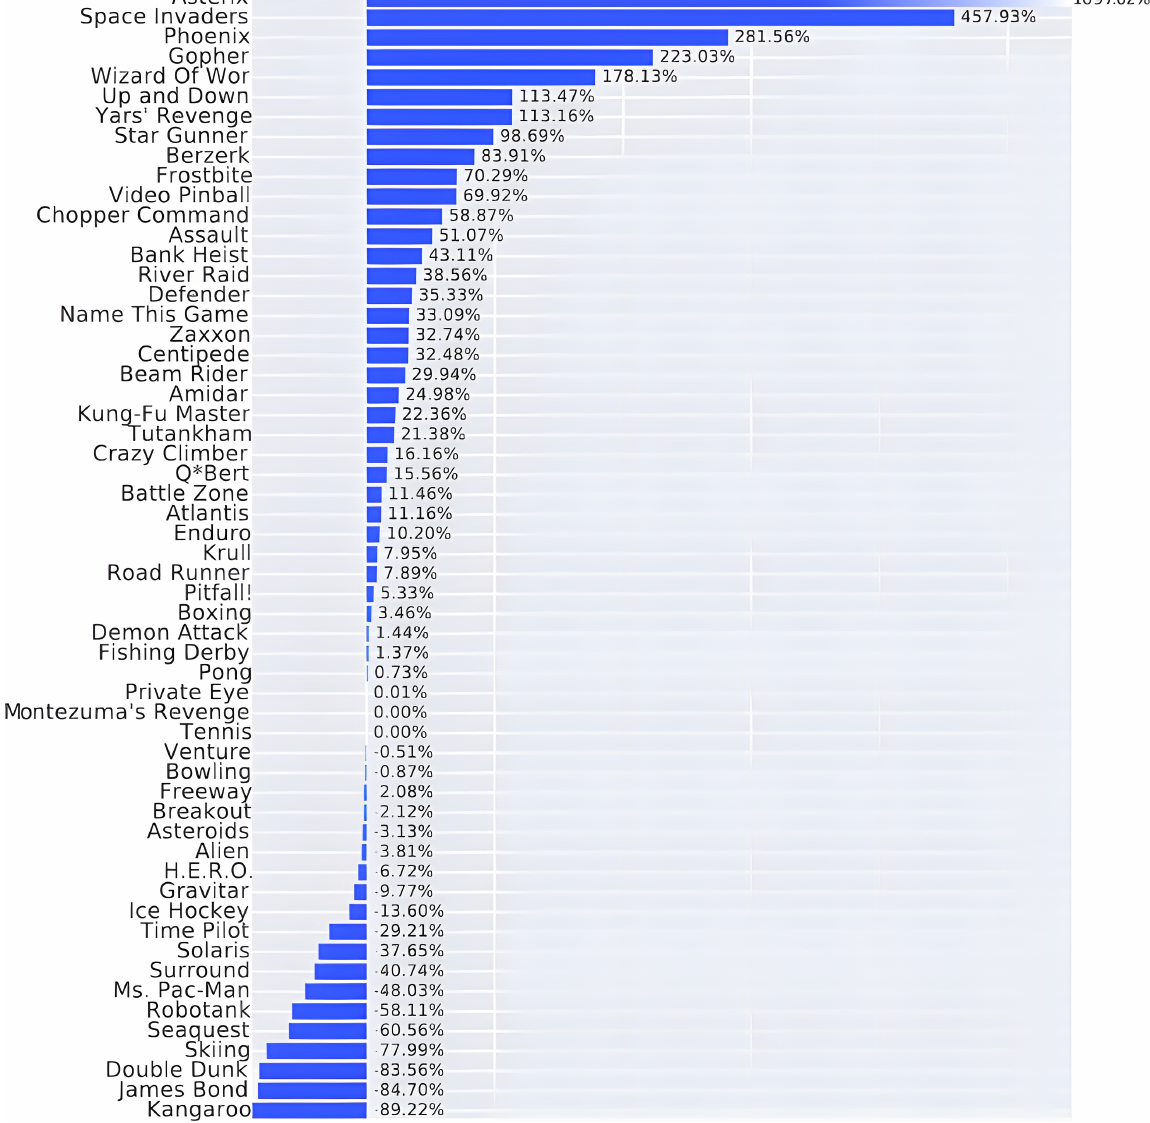
Figure 14. Performance of the Dueling architecture in ATARI games, in comparison with the Priori- tized Double DQN